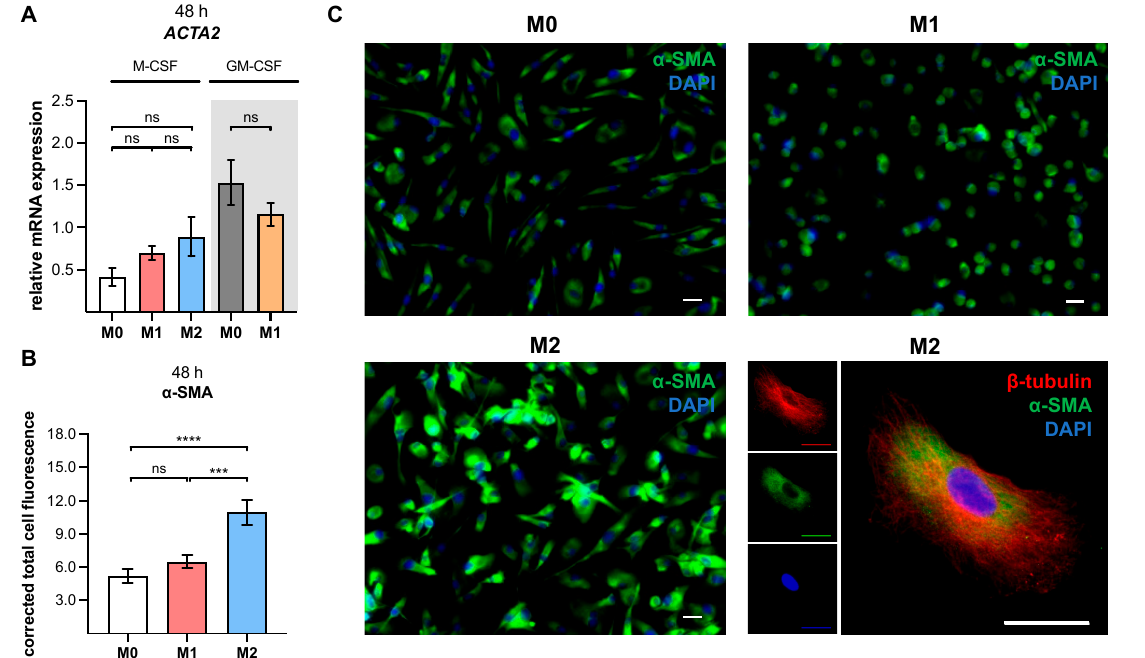
Figure 3. Analysis of an α -SMA gene, and protein expression in polarized human M Φ . Negatively selected monocytes (n, sample = 3; n, biological = 2; n, technical = 3) were differentiated into macrophages, using M-CSF or GM-CSF (highlighted in grey). After 6 days, M Φ were stimulated with IFN- γ /LPS (M1), IL-4 (M2), or with no additive (M0). ( A ) The relative ACTA2 expressions of the in vitro generated M Φ were determined via qRT-PCR, after a polarization time of 48 h. ( B ) The M-M Φ subtypes were fixed, permeabilized and immuno-stained for α -SMA (green) and β -tubulin (red), after a polarization time of 48 h. The cell nuclei were stained with DAPI (blue). Representative images of donor-derived M- M Φ cultures are shown. Scale bar = 25 μ m. ( C ) The α -SMA-corrected total cell fluorescence in human M-M Φ subtypes (n, sample = 3; n, biological = 2; n, technical = 9) was determined by analysis of the immunofluorescence images. All data were analyzed using a one-way ANOVA, followed by Tukey’s multiple comparison tests, and expressed as mean ± SEM. ns (not significant), p < 0.001 (***), p < 0.0001 (****).